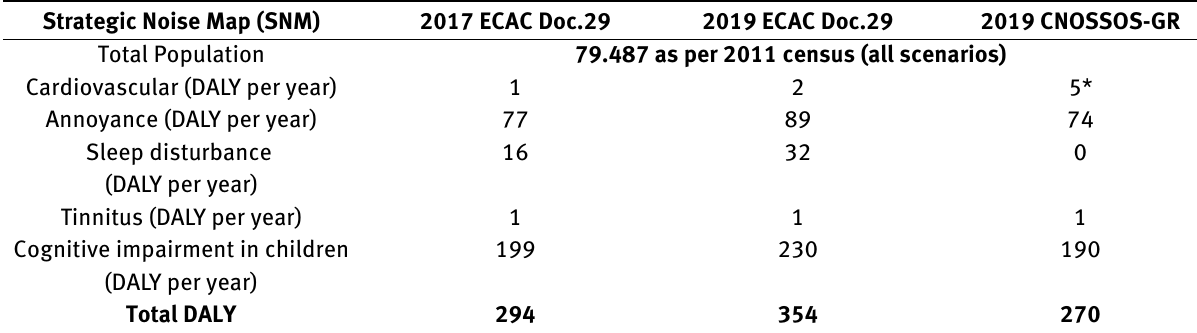
Table 5: Main results for the health burden of disease due to long term exposure noise from aircrafts Strategic Noise Map (SNM)